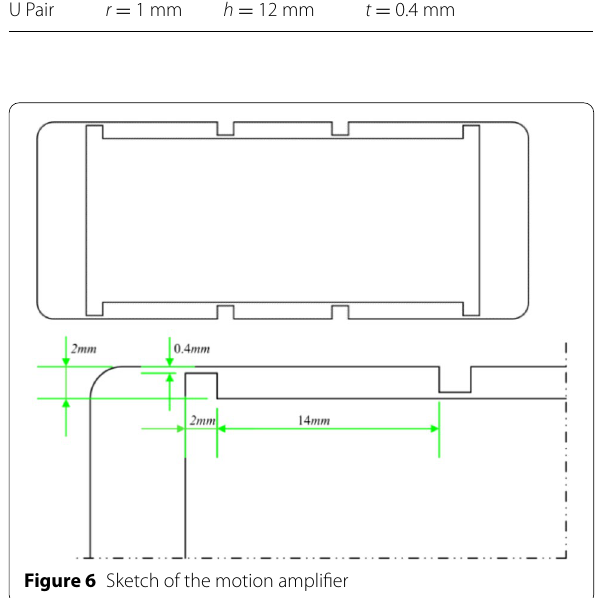
Figure 6 Sketch of the motion